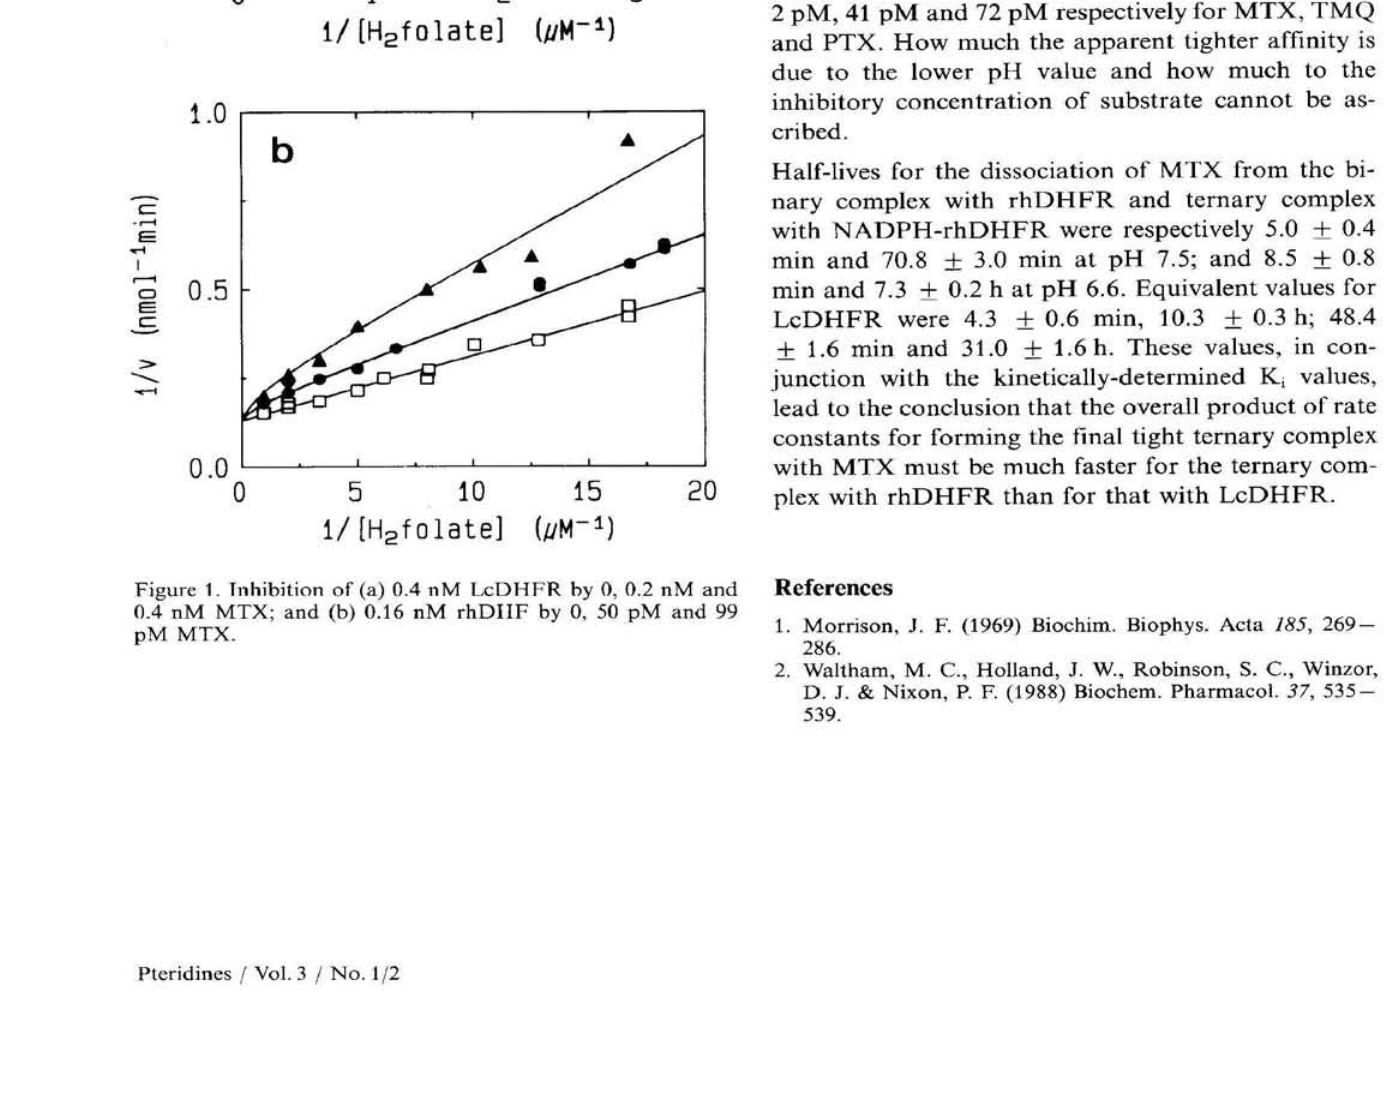
Figure 1. Inhibition of (a) 0.4 nM LcDHFR by 0, 0.2 nM and 0.4 nM MTX; and (b) 0.16 nM rhDIIF by 0, 50 pM and 99 pM